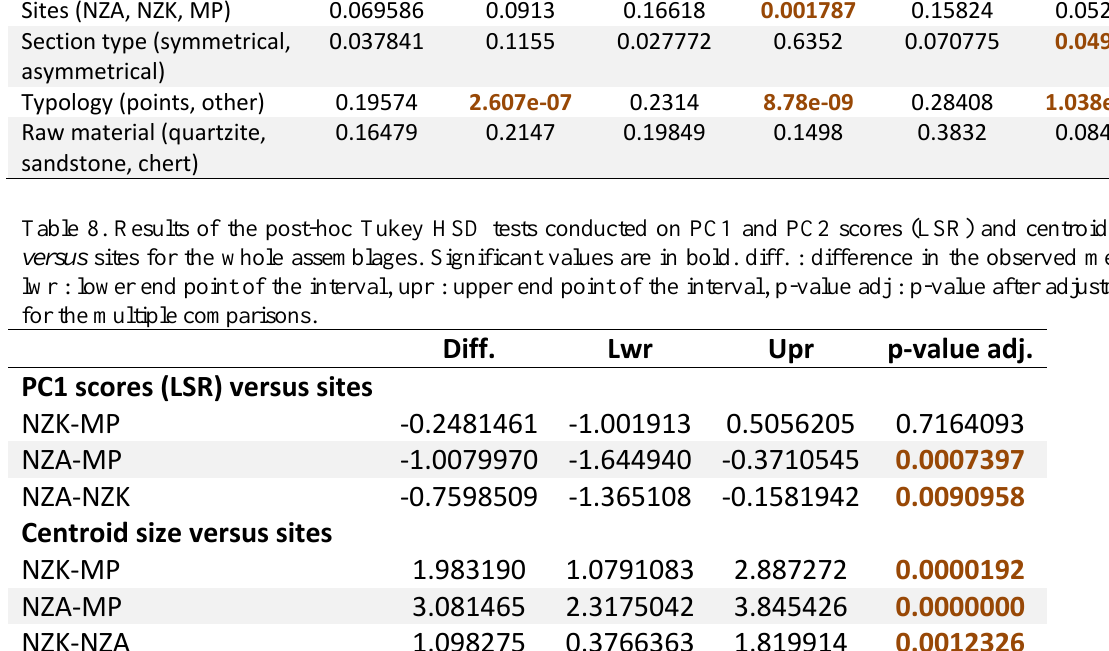
Table 7. MANOVA results realised on PC1-13 scores based on EFA coefficients, the five indices based on linear measurements and PC1-2 scores based on LSR variables for the whole assemblages. Significant values are in bold. EFA Log Shape Ratio Five indices Qualitative sup.